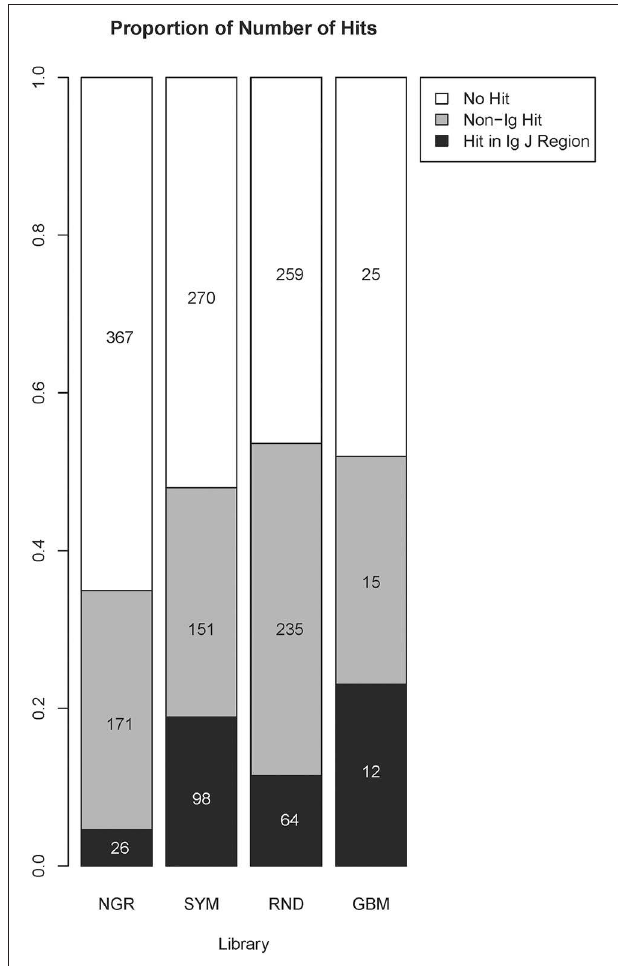
FIGURE 6 | Comparison between the number of homologous sequences found by BLAST search of the non-redundant human protein database classified as immunoglobulin J regions or non-immunoglobulin hits. The numbers and the size of the shaded bars correspond to the number of peptides having this type of homolog in the targeted database, and the proportion these peptides represent the volume of the library. A peptide was considered to be homologous to an immunoglobulin J region if the search returned at least one hit in a variable J region. The parameters were automatically adjusted for short sequences, and the results further restricted to those with a minimum of six positive positions and a minimum of six identity position. The alignment length was set equal to the number of positive positions, and no gaps were allowed. The proportions were compared using the chi-square test followed by pairwise multicomparison with false discovery rate correction (overall, p = 2 × 10 − 16 ; SYM/Ig vs. RND/Ig, p = 1.2 × 10 − 6 ; SYM/non-Ig vs. RND/non-Ig, p = 3.6 × 10 − 9 ; NGR/Ig vs. RND/Ig, p = 2 × 10 − 8 ; GBM/Ig vs. RND/Ig, p = 0.045). GBM, glioblastoma